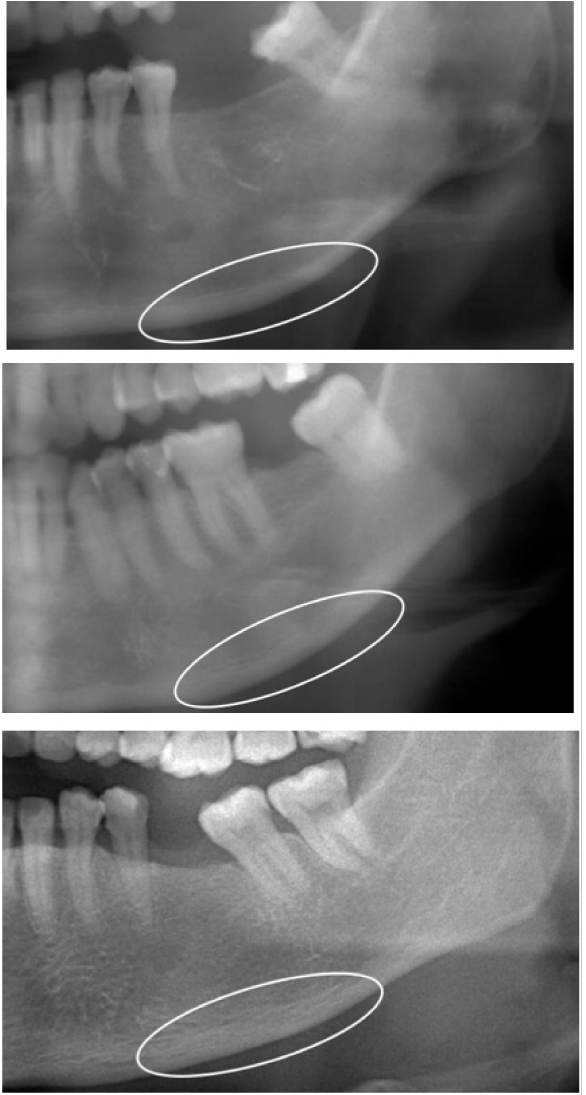
Figure 1. Mandibular cortical index (MCI). Participants were divided into three categories (C1–C3) according to the MCI. Class 1 (normal cortex): the endosteal margin of the cortex was even and